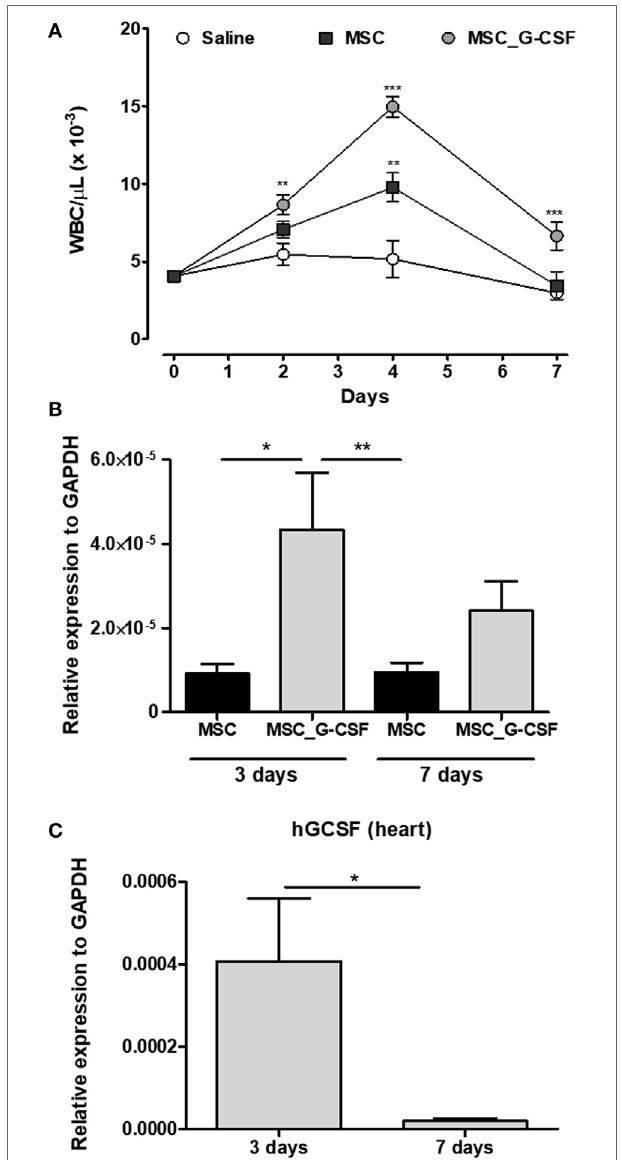
FigUre 1 | MSC_G-CSF increases peripheral blood leukocyte counts and present enhanced ability to migrate to the heart. (a) Naïve mice were i.p. injected with mesenchymal stem cells (MSCs), MSC_G-CSF, or saline. Leukocyte counts were determined before the injection and in the following days. Values represent mean ± SEM of five mice/group. ** P < 0.01 and *** P < 0.001 compared to saline-treated mice. (B,c) Trypanosoma cruzi -infected mice (6 months of infection) were transplanted with one dose of 10 6 MSCs or MSC_G-CSF. Heart tissue was collected 3 or 7 days later for RT-qPCR analysis of GFP (B) or human granulocyte-colony stimulating factor (c) . Values represent the mean ± SEM of 4–6 mice/group. * P < 0.05 and ** P <